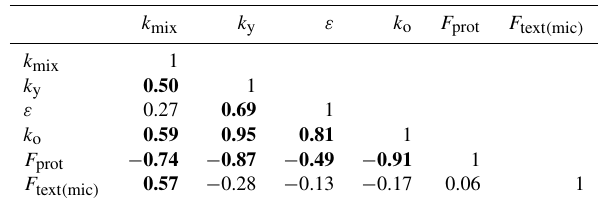
Table 3. Correlation matrix for parameter estimates for the 36 best parameter sets of 100 calibration runs against synthetic data for soil bulk density, SOC and microporosity (Fig. 6). Values highlighted in bold show a significant correlation ( p< 0 .